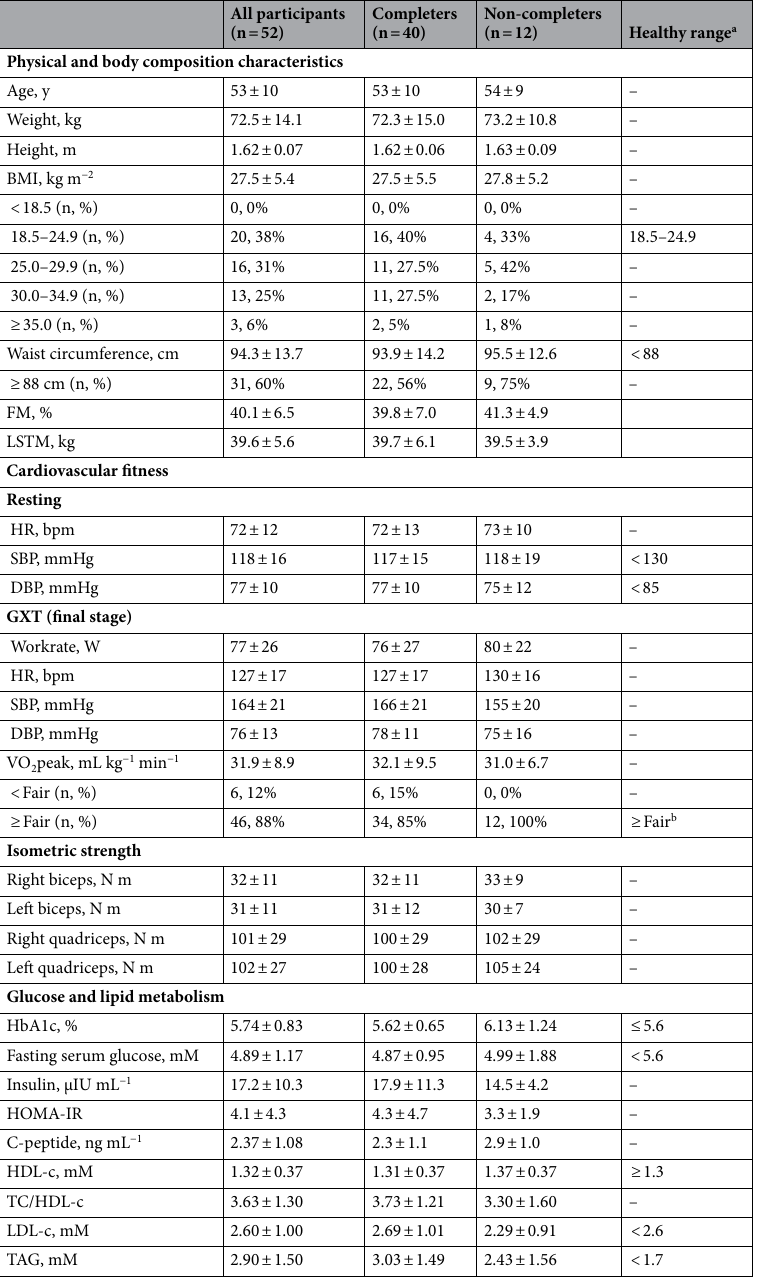
Table 1. Baseline characteristics. Data are mean ± SD unless otherwise indicated. No significant differences between completers and non-completers. a Based on reference values established by the International